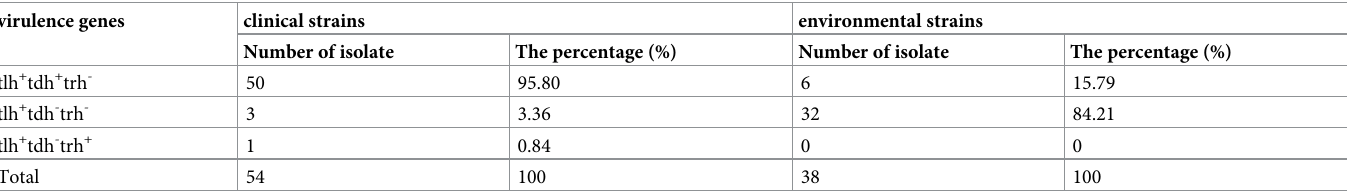
Table 2. Virulence genes of 92 V . parahaemolyticus isolates from clinical and environmental samples in Huzhou.